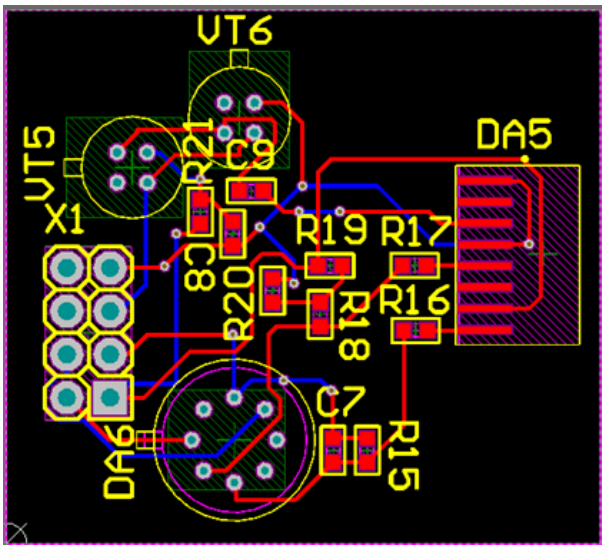
Fig. 2. Circuit board of the prototype of the third axis of the magnetometer for the inertial positioning